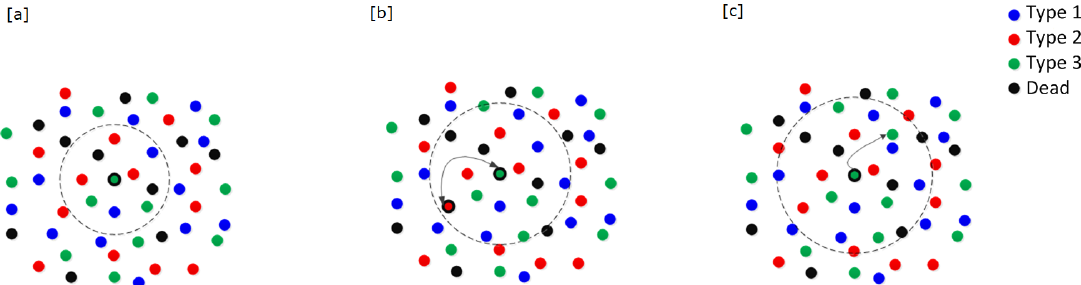
( a ) Density-dependence neighborhood: A focal cell can only proliferate if the density of cells within the disc defined by the density-dependence radius is below a threshold. ( b ) Frequency-dependence neighborhood: The focal cell’s likelihood of proliferating will be determined from an interaction between it and a randomly selected cell from within the frequency-dependence radius. ( c ) Dispersal neighborhood: If a focal cell proliferates, its daughter cell is placed randomly within the disc defined by the dispersal radius. Adapted from [13]. All the radii may vary with blood-vessel